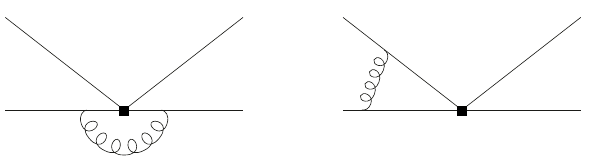
Figure 2 . Examples of factorizable (left panel) and non-factorizable (right panel) diagrams. The renormalization factors Z ij , Z (cid:11) , (cid:14)m , and Z ext account for operator, coupling, mass, and wave-function renormalization, respectively. The coupling is renormalized in the MS scheme, whereas the mass and the (cid:12)elds are renormalized in the on-shell scheme. In the matrices Z ij the row index runs over i = f Q p